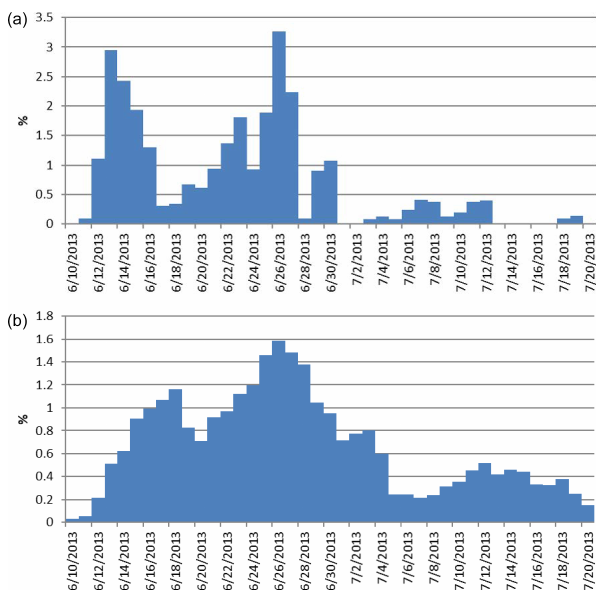
Figure 2. In the 4km SENEX domain, (a) the contribution (%) of CO emission from fires that occurred inside the SENEX domain and (b) the contribution (%) of CO flux flowing into the SENEX domain from its boundary caused by fires burning outside the SENEX do- main but inside the CONUS domain.